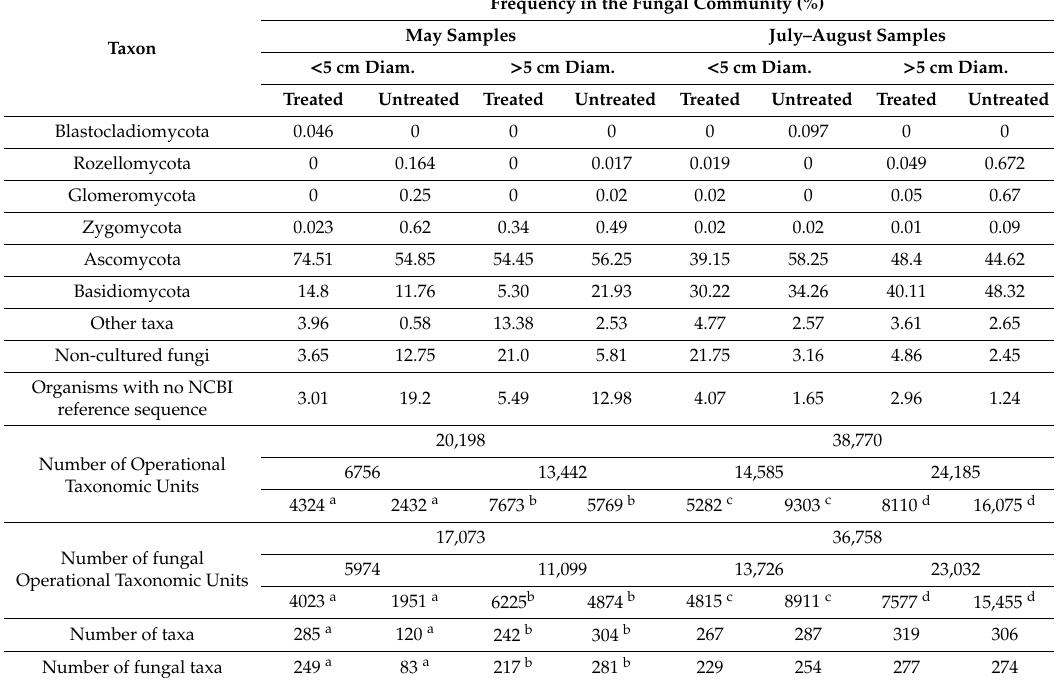
Table 1. Fungi in stump wood of P. serotina in relation to sample time, stump diameter and glyphosate treatment.